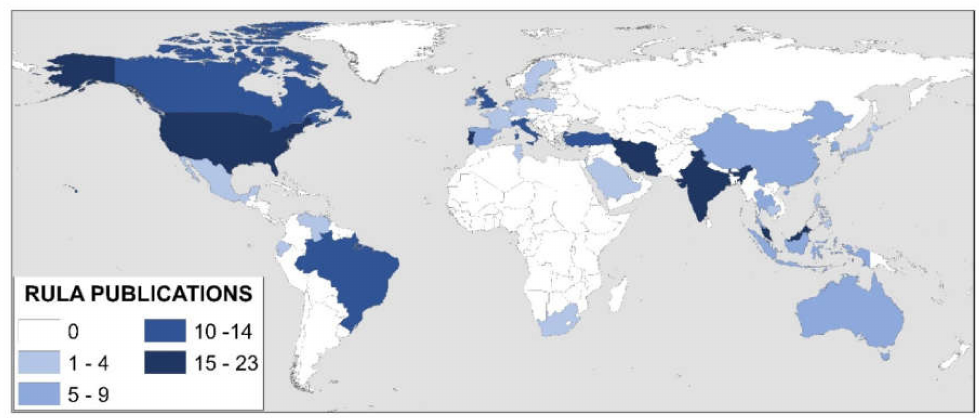
Figure 6. Map with frequencies.